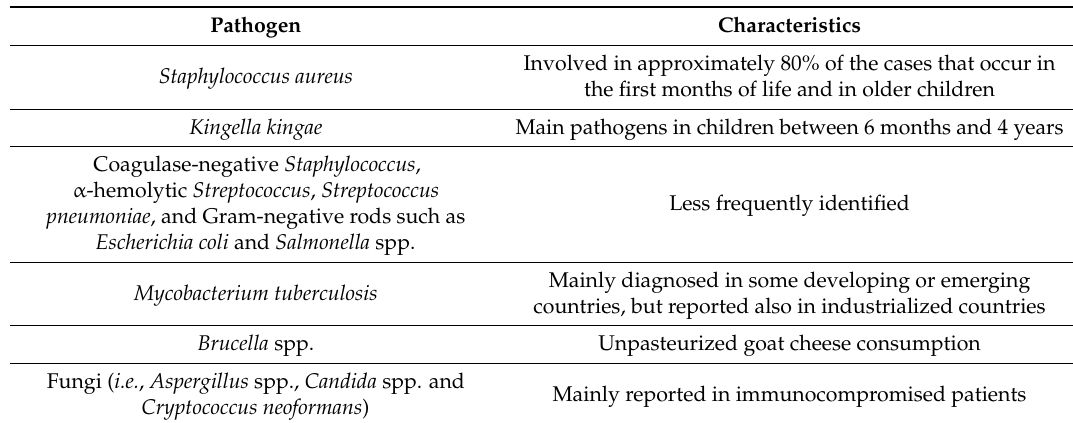
Table 1. Main etiologic agents for discitis (D) and spondylodiscitis (SD) in pediatric age and their